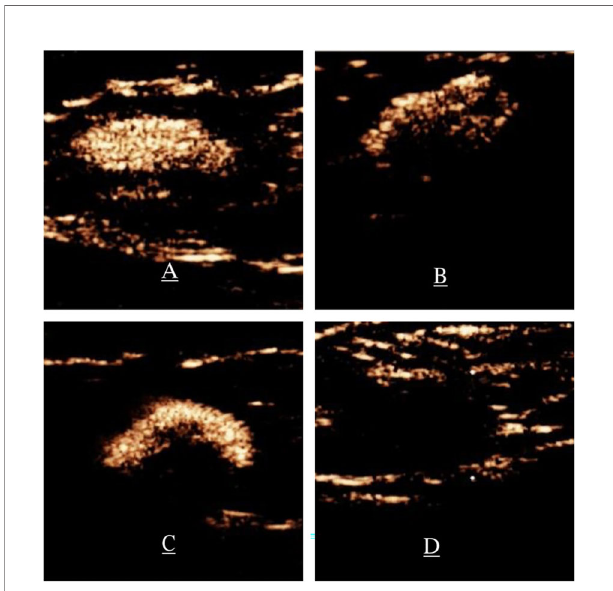
FIGURE 1 | Patterns of enhancement on P-CEUS. (A) Type I, homogenous enhancement. (B) Type II, heterogeneous enhancement, signi fi cantly enhanced parenchymal areas of focal hypoperfusion or non-perfusion. (C) Type III, complete or incomplete circumferential ring enhancement and low or no central enhancement. (D) Type IV, slight enhancement or no enhancement. P-CEUS: percutaneous contrast-enhanced